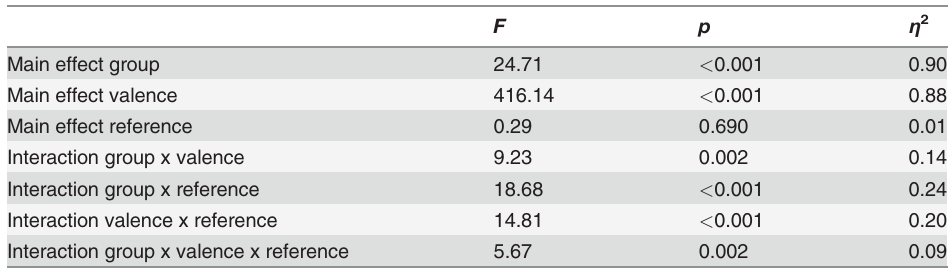
Table 3. Results of the repeated measures ANOVA of word valence ratings with group (healthy controls, Borderline Personality Disorder patients), valence (negative, neutral, positive) and reference (article, self-reference,